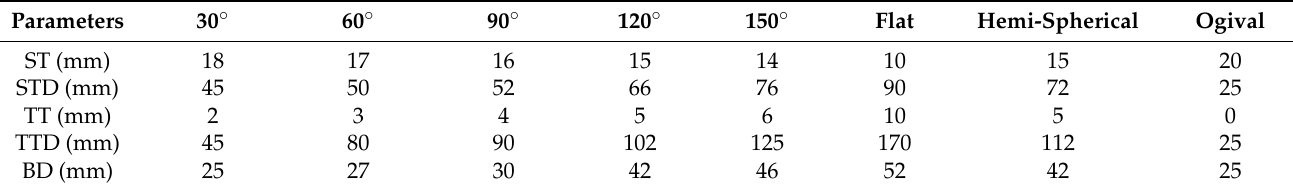
Table 6. The deformation parameters of the UHMWPE composite in